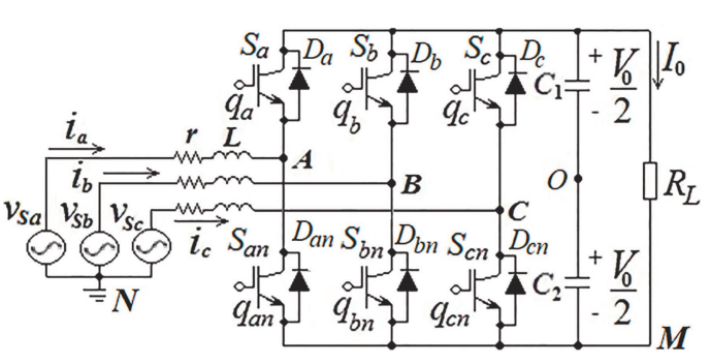
Figure 11. Electrical diagram of the PWM rectifier used on the experimental setup.